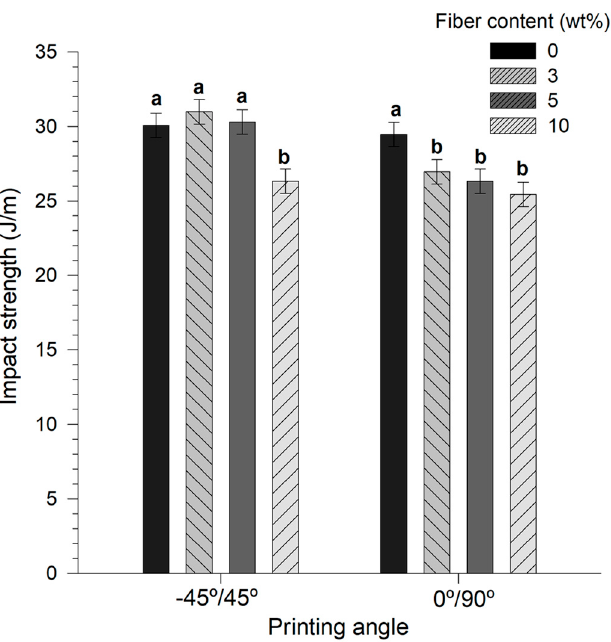
Figure 6. Charpy impact strength of printed agave fibers/PLA biocomposites. The letters a–b on top of the bars indicates significant differences ( p < 0.05).